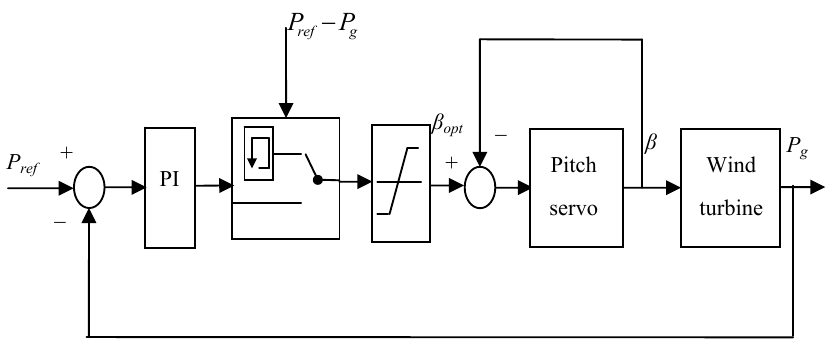
Figure 5. Proposed PI fluctuation pitch angle control